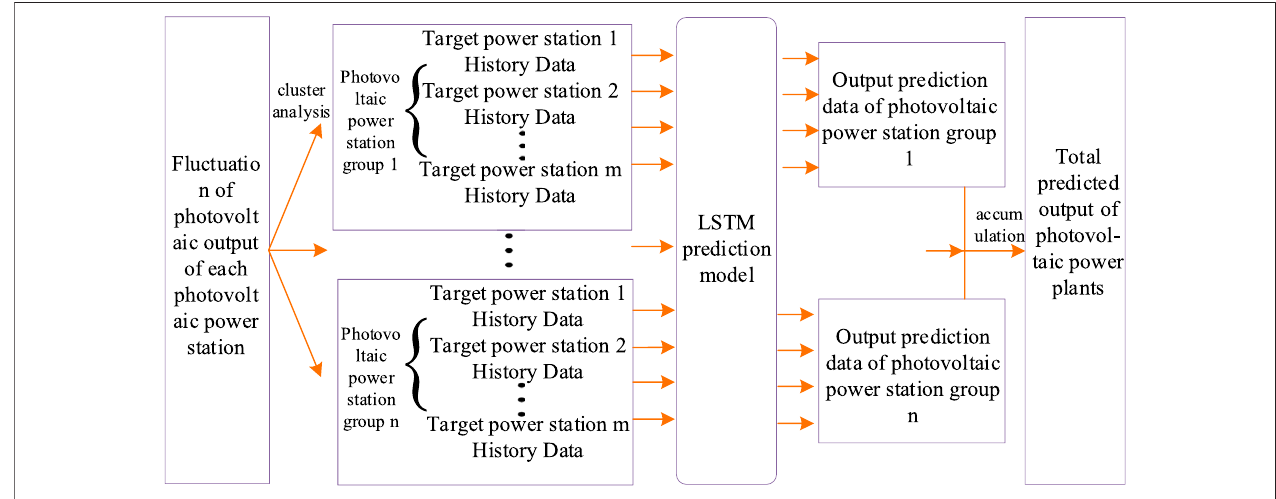
FIGURE 2 | Structural diagram of photovoltaic output prediction model considering spatial correlation